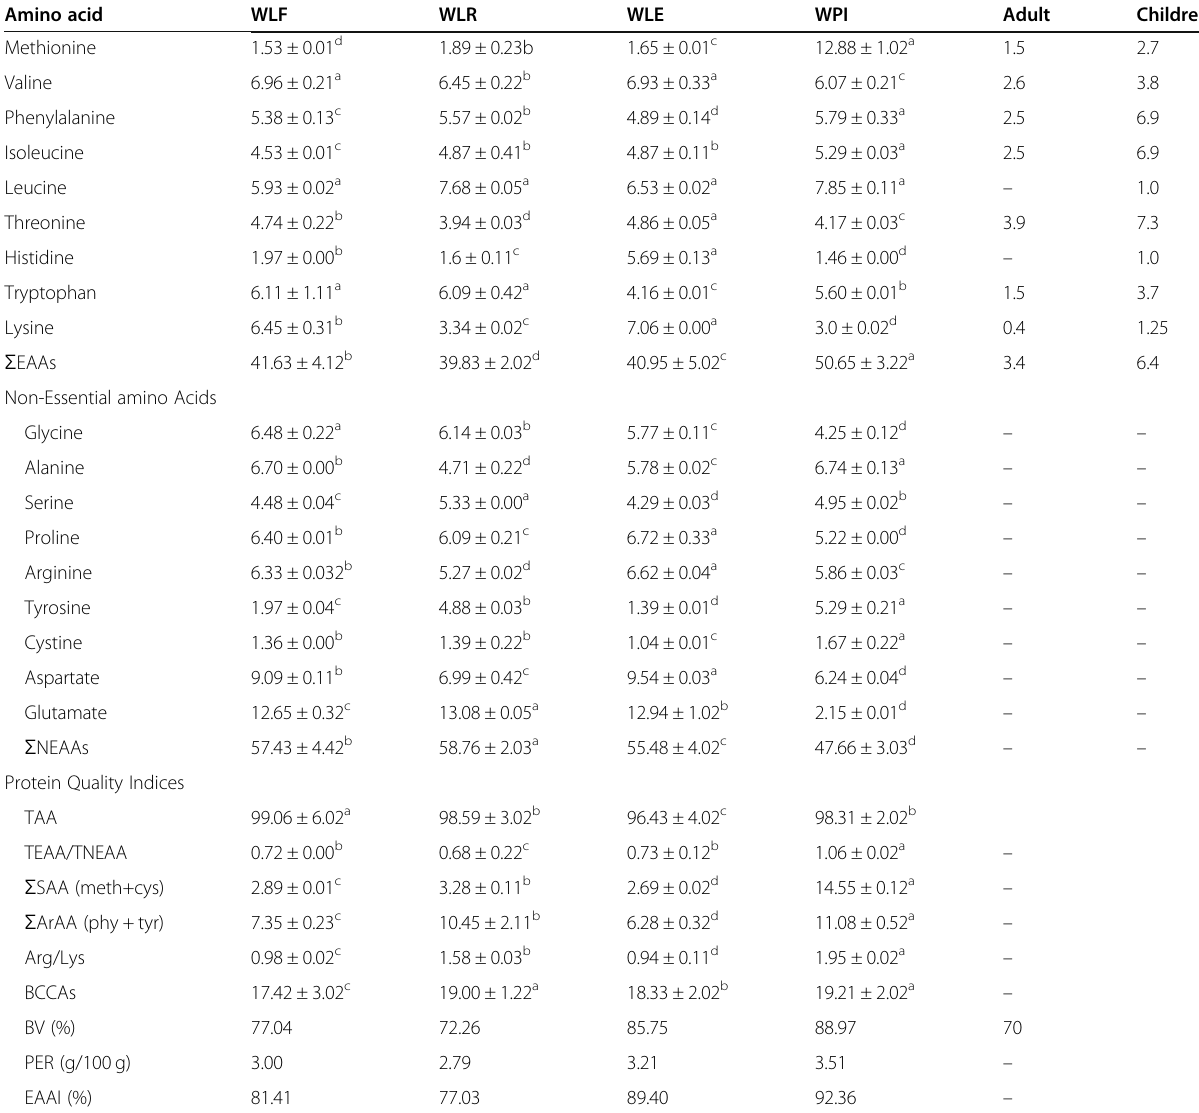
Table 3 Amino acid profile (g/100 g protein) of African wild lettuce leaves Amino acid WLF WLR WLE WPI Adult Methionine